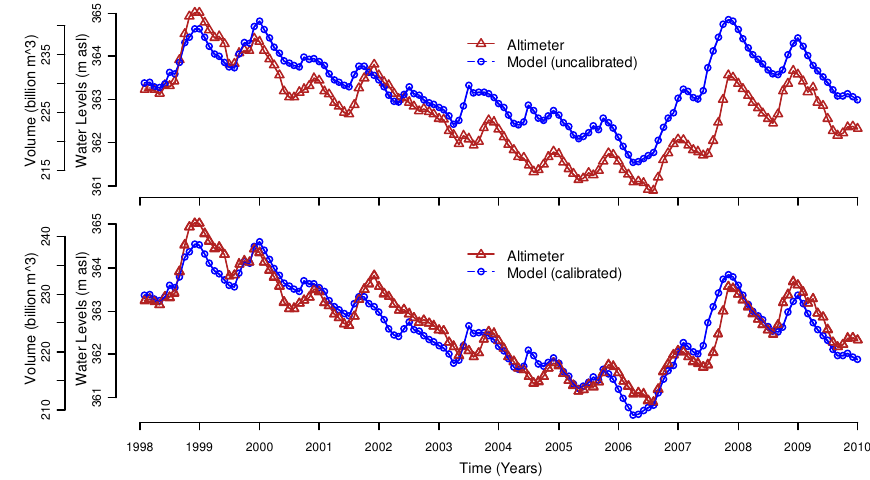
Fig. 6. Comparison of Lake Turkana water levels modelled using the LLM approach and satellite altimetry data: (a) un-calibrated lake levels [ ε =0]; (b) calibrated lake levels for magnitude [ ε =0.06mday − 1 ]. The calibration is performed on data from 1998 to 2003 and the model is validated using data from 2004 to